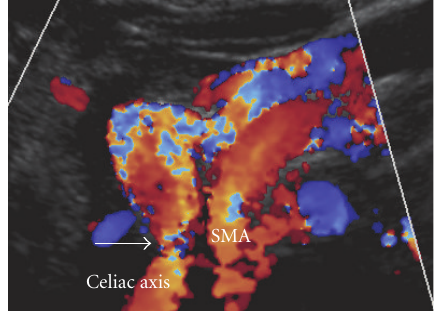
Figure 4: Color ultrasound study at 3-month follow up shows focal residual stenosis at proximal celiac artery.